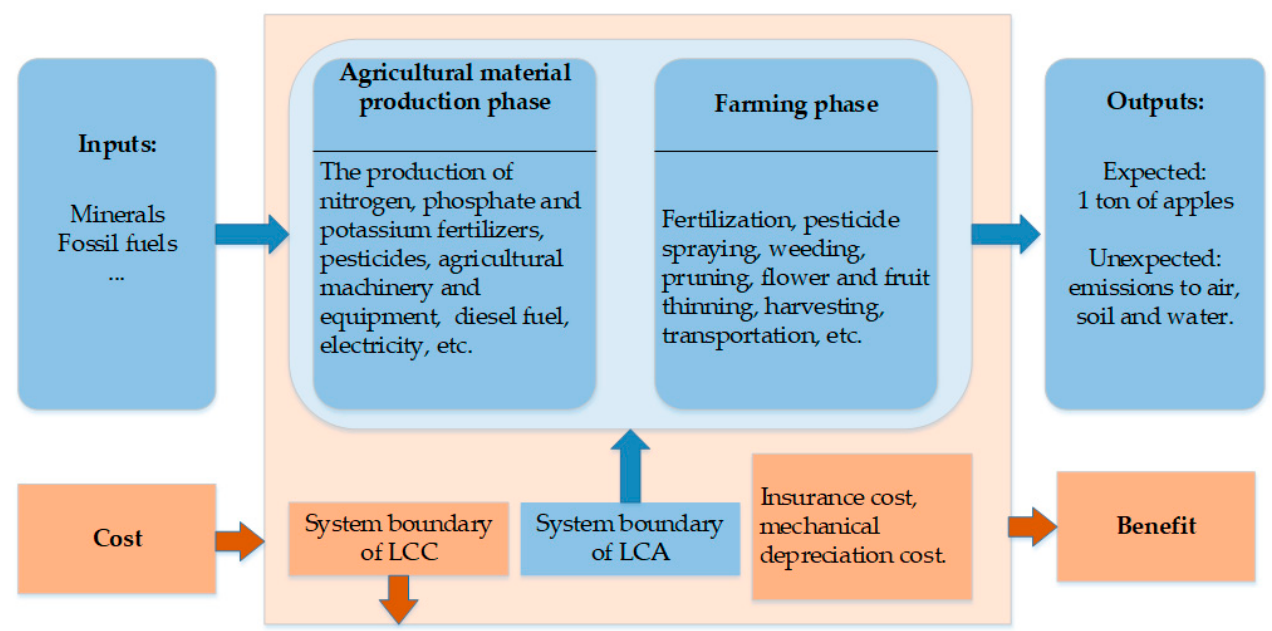
Figure 2. System boundary for a life cycle assessment of the apple production system.